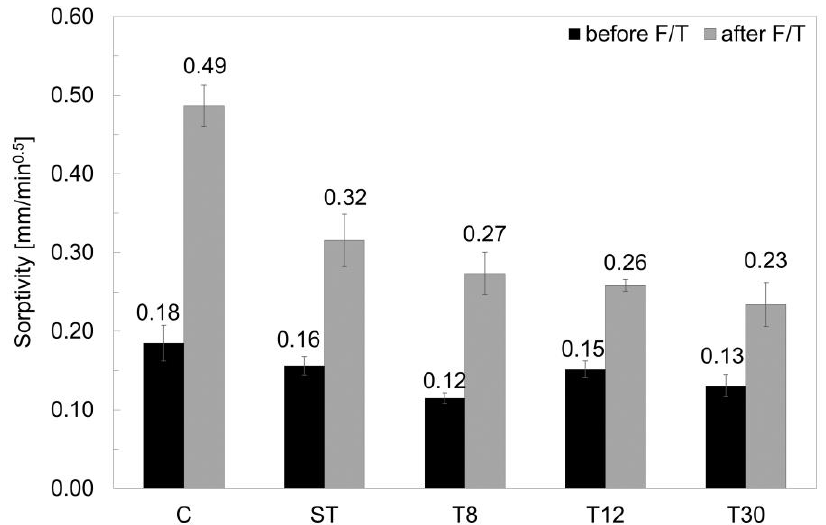
Figure 10. Sorptivity values of series C, ST, T8, T12 and T30 before and after freeze/thaw cycles. The error bars represent the standard deviation.